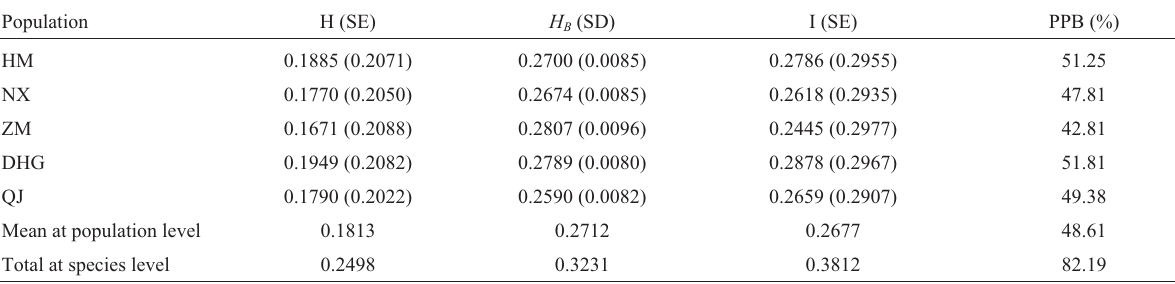
Table 3 - Genetic diversity indices of the five populations of R. tanguticum. Population